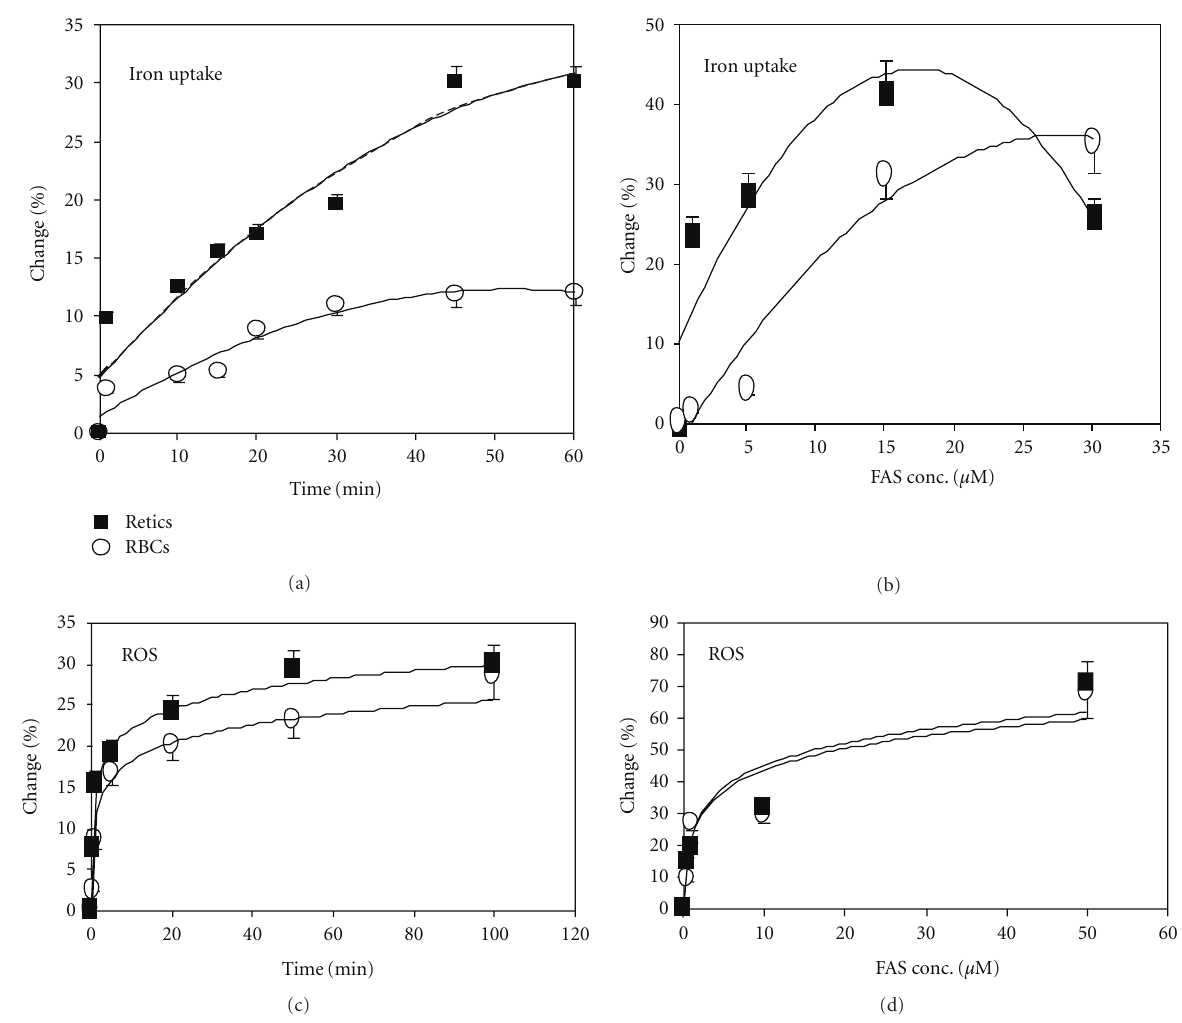
Figure 2: Time- and dose-related iron uptake and ROS generation by RBCs and reticulocytes. Normal peripheral blood cells were labeled, suspended in their autologous plasma and incubated with or without FeSO 4 (FAS) as described in the legends to Figure 1. (a, c) Labeled cells were incubated with or without 20 μ M FAS for the indicated durations. (b, d) Labeled cells were incubated with the indicated concentrations of FAS for 1 hr. The results of iron uptake (a, b) and ROS generation (c, d) in RBCs ( ◦ ) and retics ( change (mean ± SD, N = 4) in the MFIs following incubation with and without Fe, calculated per the MFI − Fe.